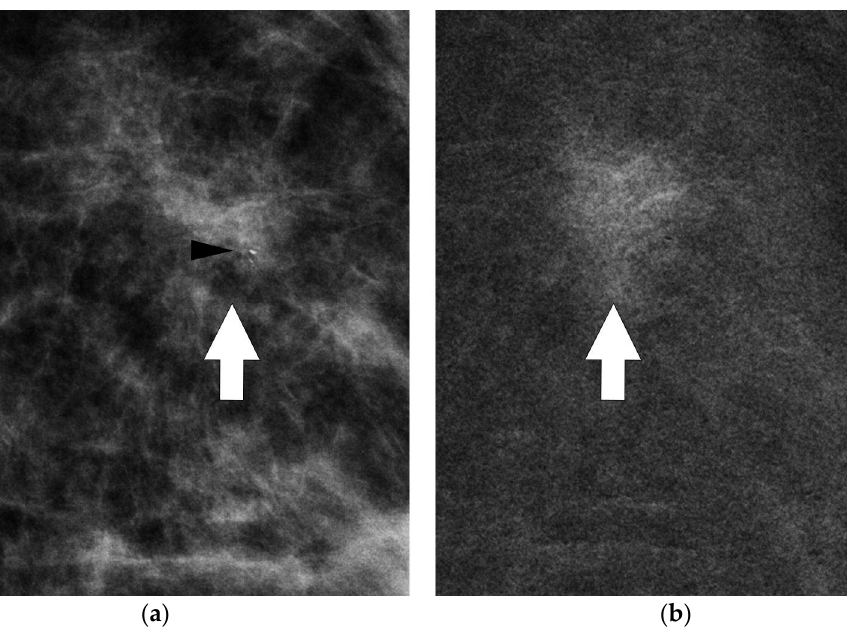
Figure 6. Mammographic magnifications of conventional ( a ) and CESM ( b ) MLO projections of the left breast. Thick white arrows point to tumor site ( a , b ). Microcalcifications were confirmed within the enhancing lesion (black arrowhead), allowing a mammographically guided biopsy approach. The combination of mammographic findings and the perfusion pattern improve the detection of minimal signs. Therefore, minimal signs not relevant at conventional mammography become significant after contrast medium administration and can be a target for stereotactic guided biopsy.